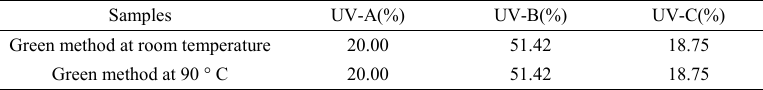
Table 1. The percentage of UV-A, UV-B and UV-C radiation of ZnO NPs